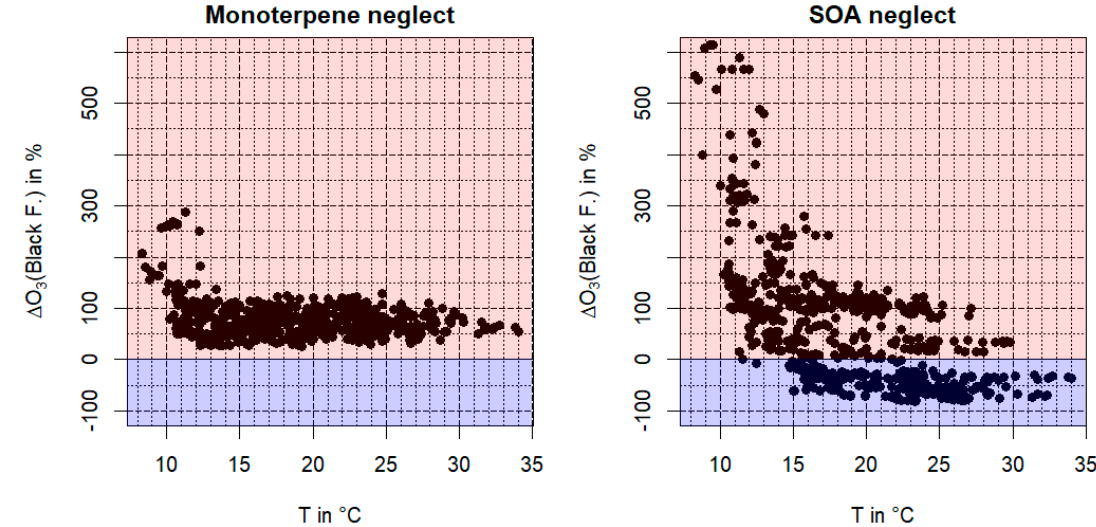
Figure 9. Effect of neglect on ozone calculated, left : monoterpenes; right : secondary organic aerosol.